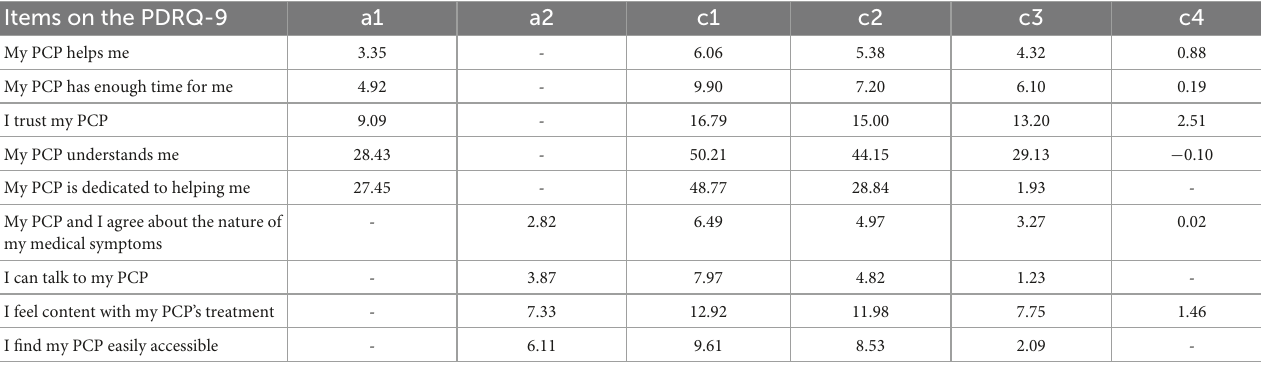
TABLE 4 Item content of patient-doctor-relationship questionnaire (PDRQ-9) full scale and multidimensional item response theory (MIRT) item parameter estimates. Items on the PDRQ-9